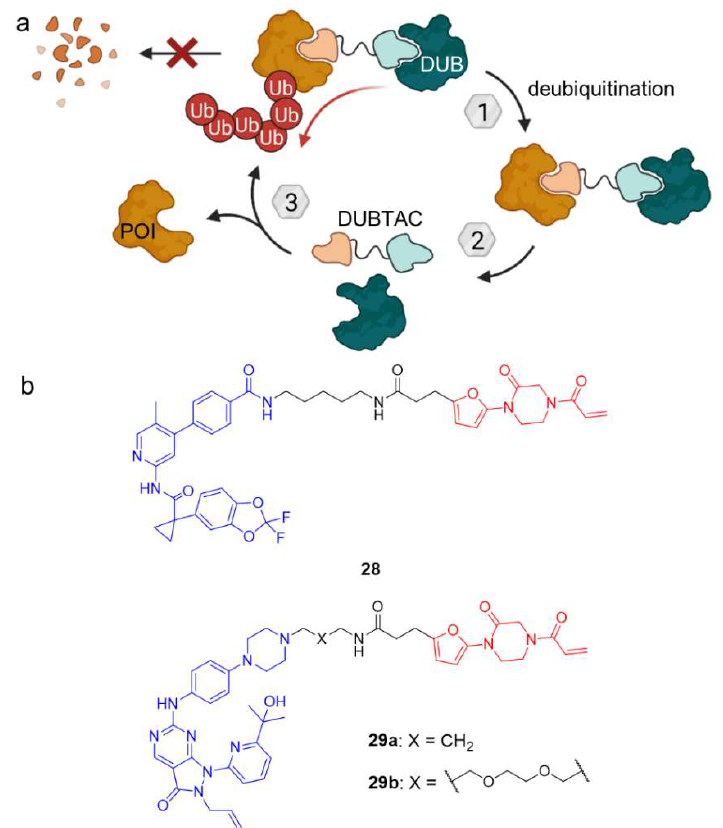
Figure 15. ( a ) Deubiquitinase-targeting chimeras (DUBTACs) mediate removal of ubiquitin degradation marks and thus stabilize target proteins. ( b ) DUBTACs 28 and 29 are composed of a POI ligand (blue), a linker unit, and a covalent allosteric ligand of the OTUB1 deubiquitinase (red). In case of 28 , the POI ligand is the corrector of the cystic fibrosis transmembrane conductance regulator (CFTR) lumacaftor, whereas 29 features an inhibitor of tumor suppressor kinase WEE1. In contrast to PROTACs, DUBTACs induce POI deubiquitination and thus stabilize protein levels.